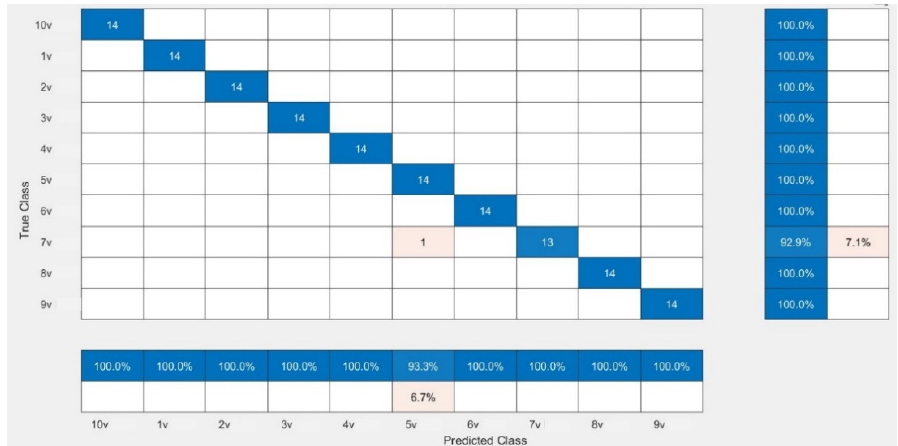
Figure 5. Confusion matrix showing the validation performance of MobileNetV2.